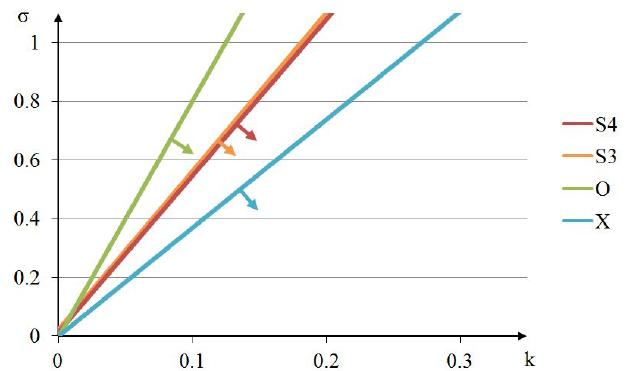
Figure 19. Lines of extreme properties for selected tensegrity